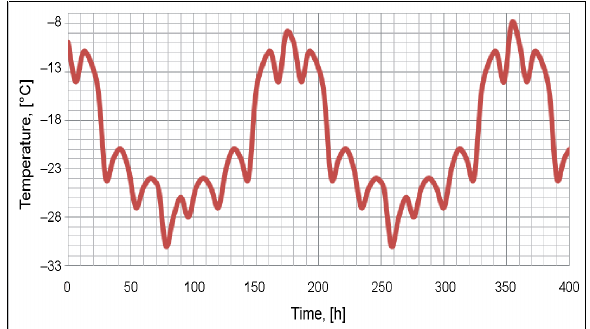
Fig. 2. “Extreme” outdoor temperature prognosis curve used for building simulation